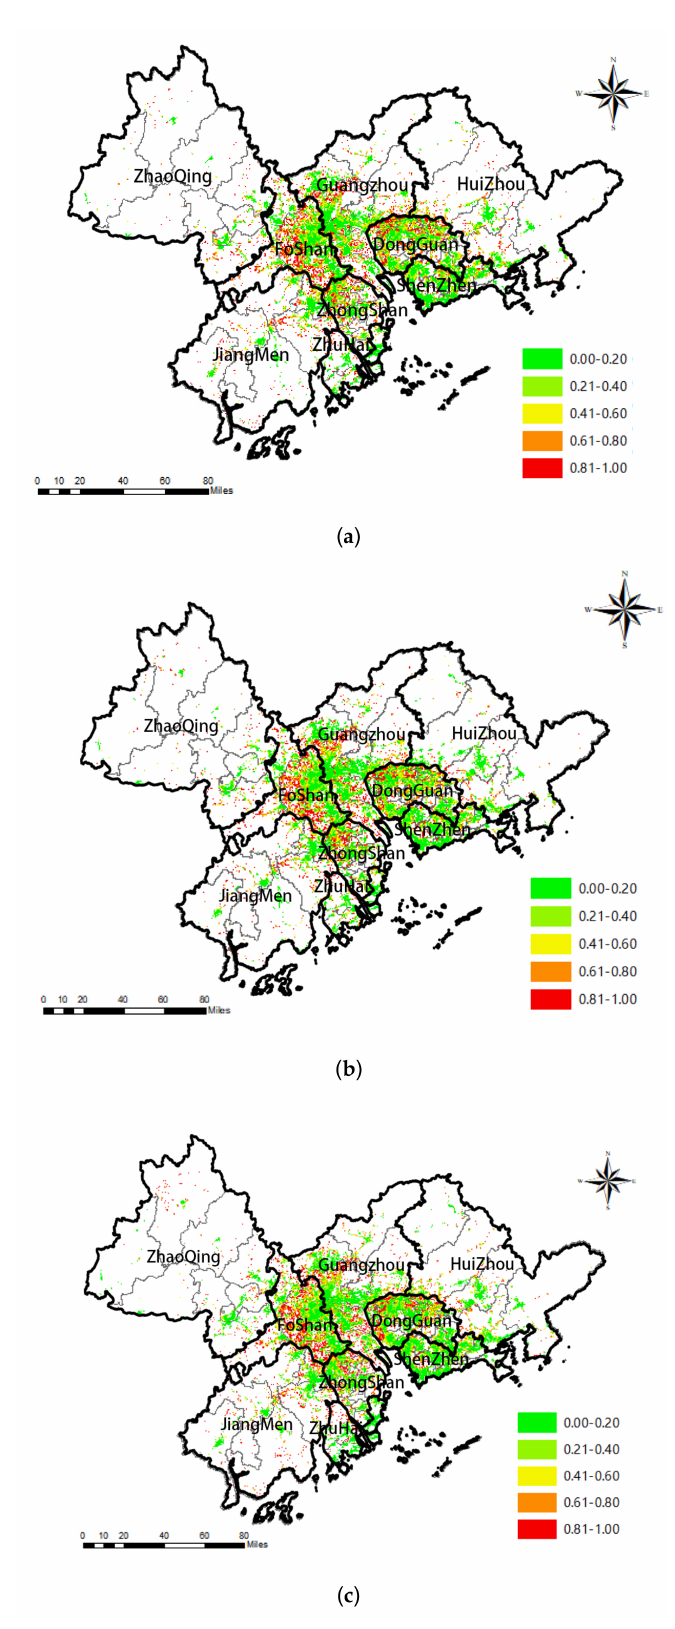
Figure 7. HVRs at pixel scale in the PRD. ( a ) 2013, ( b ) 2016, ( c )